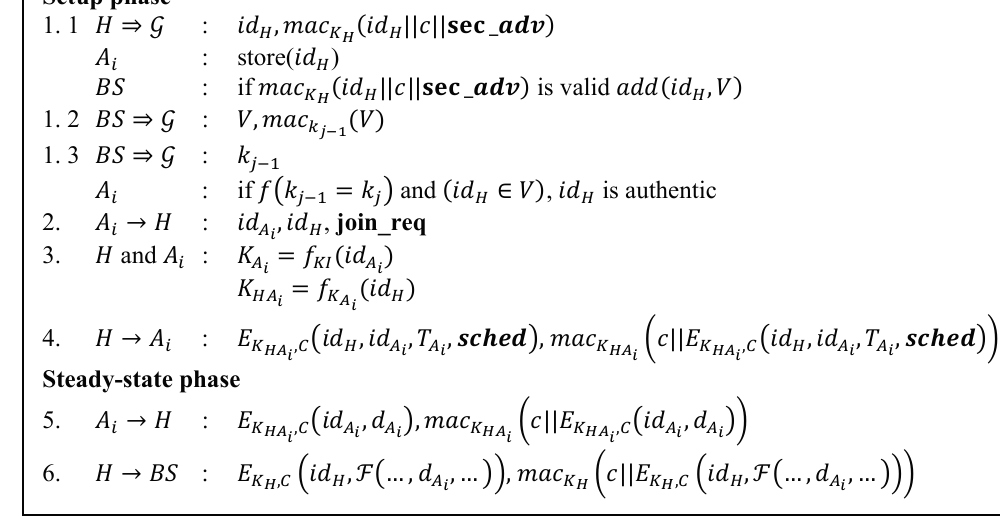
Figure 4. MS-LEACH protocol.